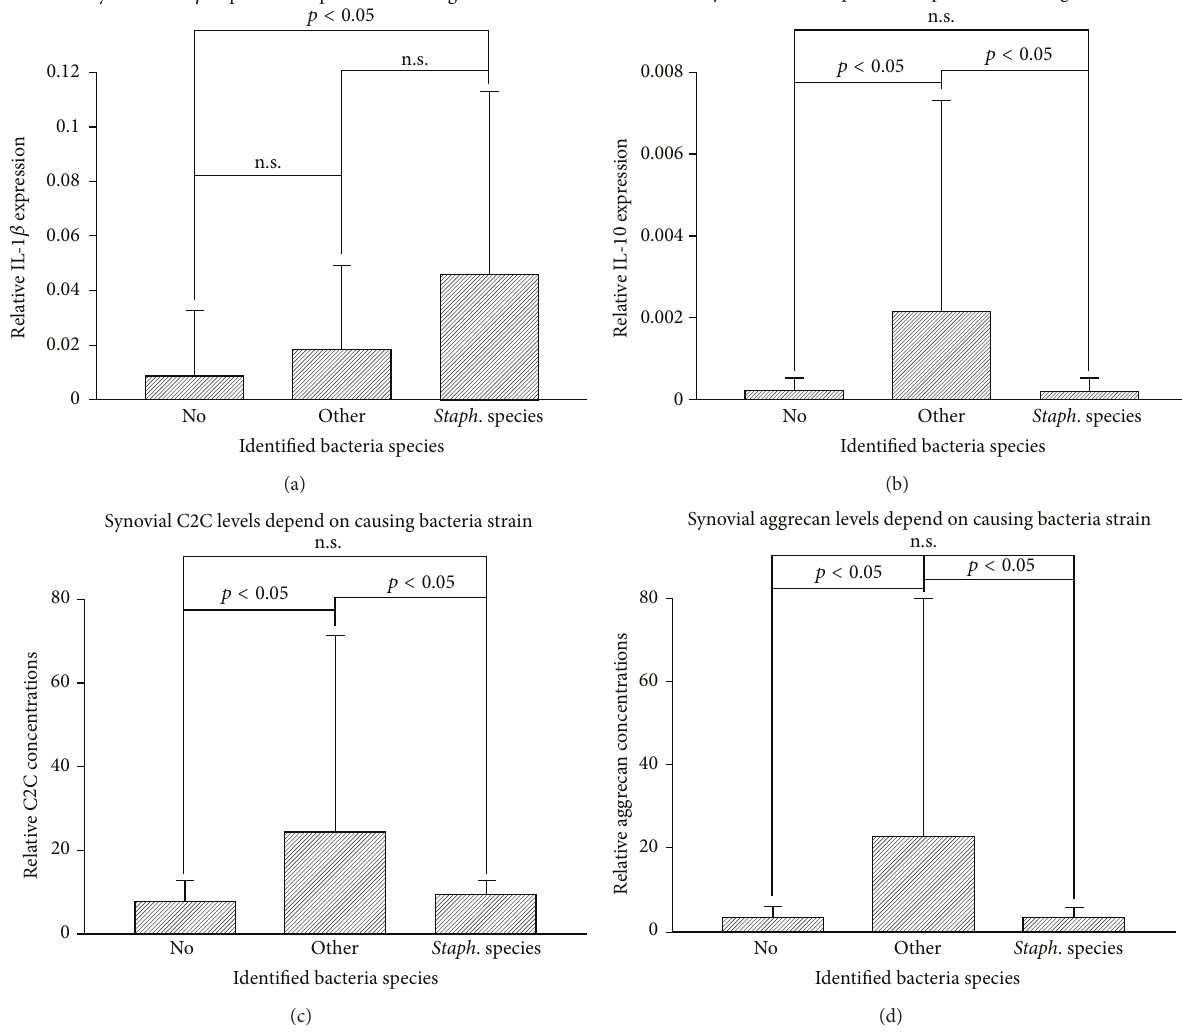
Figure 4: (a) The highest synovial IL-1 𝛽 levels were observed following infections with Staphylococcus species. (b) A different expression pattern was observed for IL-10, showing the highest levels in the group following infections with other bacteria. (c) The expression pattern for C2C, indicating cartilage destruction, is similar to IL-10, showing the highest levels in the group following infections with other bacteria. Results represent values × 10 −6 . (d) The expression pattern for another cartilage breakdown marker, aggrecan, is similar to C2C, showing the highest levels in the group following infections with other bacteria. The significance levels indicated represent the ANOVA. no: no detection of bacteria; other: infections with other bacteria; Staph . species: infections with Staphylococcus species.